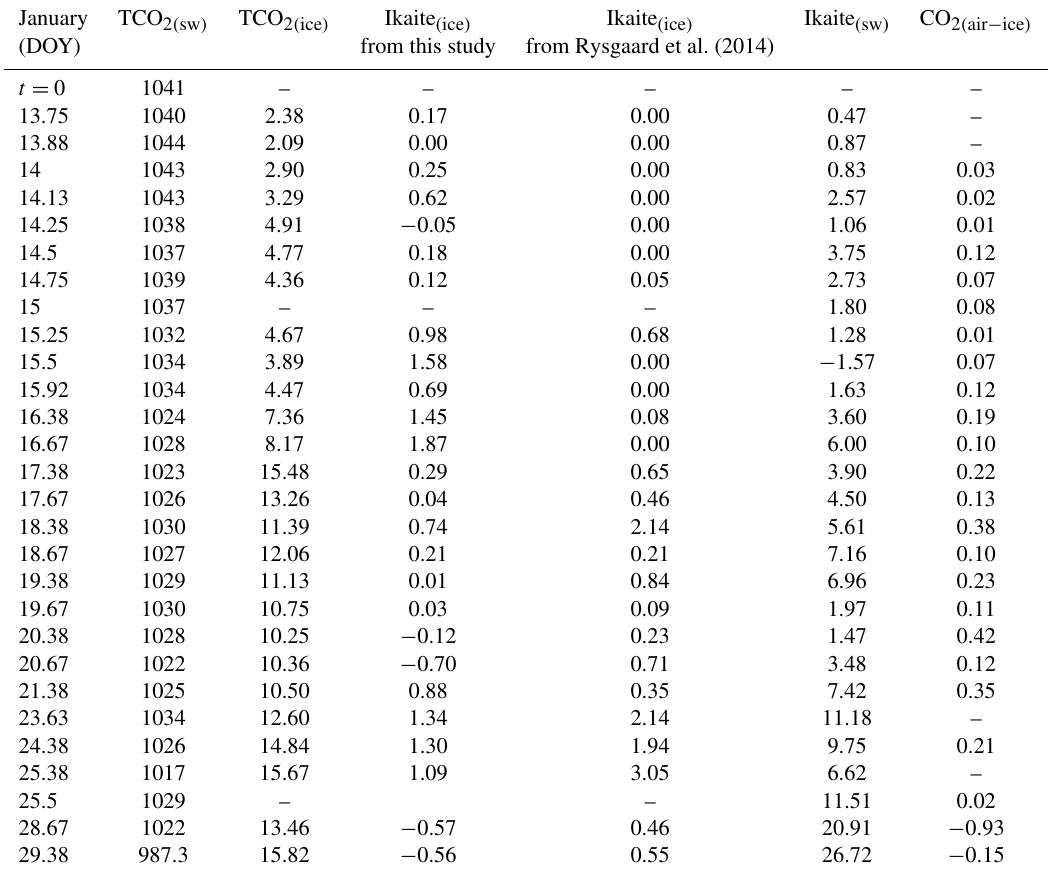
Table 2. Masses of TCO 2 in the water column (TCO 2 ( sw ) ) and in the ice cover (TCO 2 ( ice ) ), masses of ikaite within the ice cover estimated from this study and from Rysgaard et al. (2014), masses of ikaite dissolved in the water column (Ikaite (sw) ) and masses of CO 2 exchanged between the ice and the atmosphere over the whole pool (estimation based on the air–ice CO 2 fluxes). All units are in